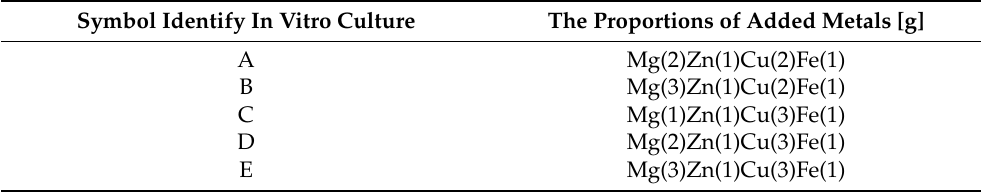
Table 2. Amounts of metal additives in the medium selected for optimal in vitro culture of A. bisporus . Symbol Identify In Vitro